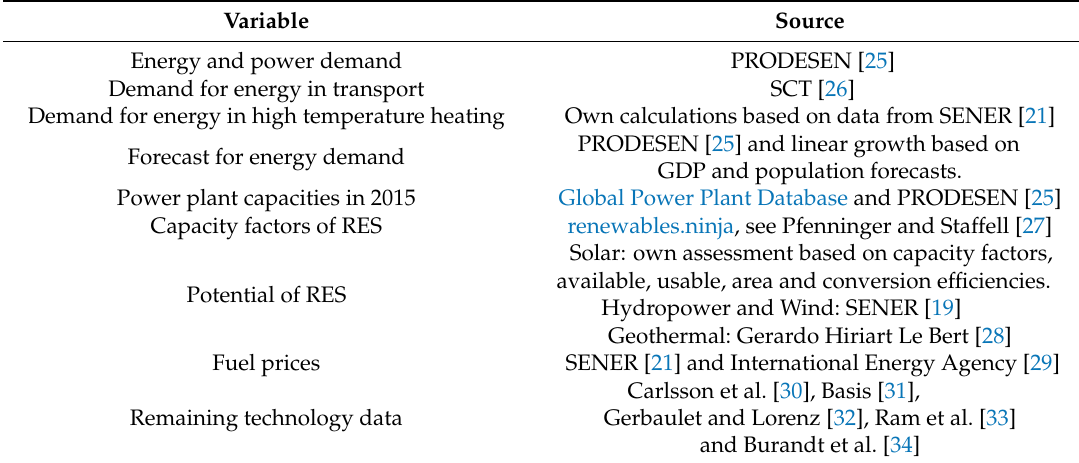
Table 1. Key sources for demand and technology data.